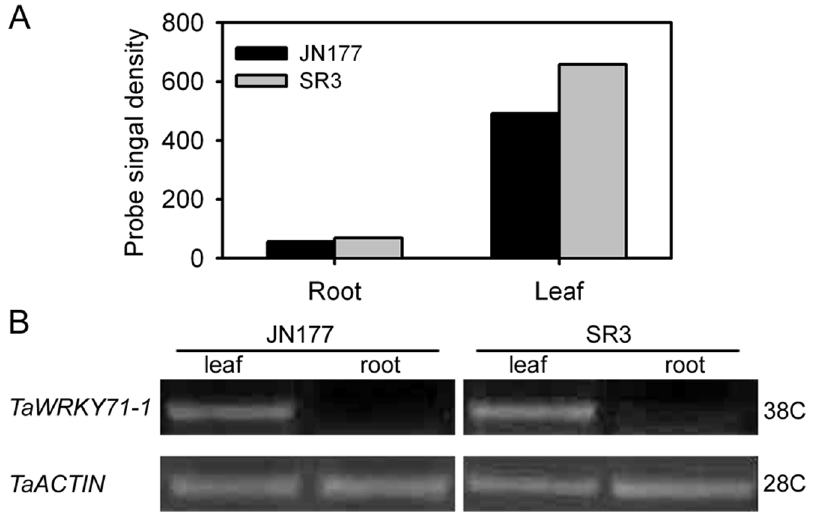
Figure 1. TaWRKY71-1 are specifically transcribed in wheat leaves with a higher expression level in SR3. A: The hybridization signals of the probe referring to TaWRKY71-1 in the microarray using wheat seedlings harvested at three-leaf stage. Data present as mean 6 standard deviation. B: The sqRT-PCR using two-week old wheat seedlings. A wheat actin gene was used as the internal reference. JN177, a common wheat cultivar; SR3, a wheat introgression cultivar selected from somatic hybrids between JN177 and its close relative grass Thinopyrum ponticum via asymmetric somatic hybridization. 28C, 28 cycles; 38C, 38 cycles.